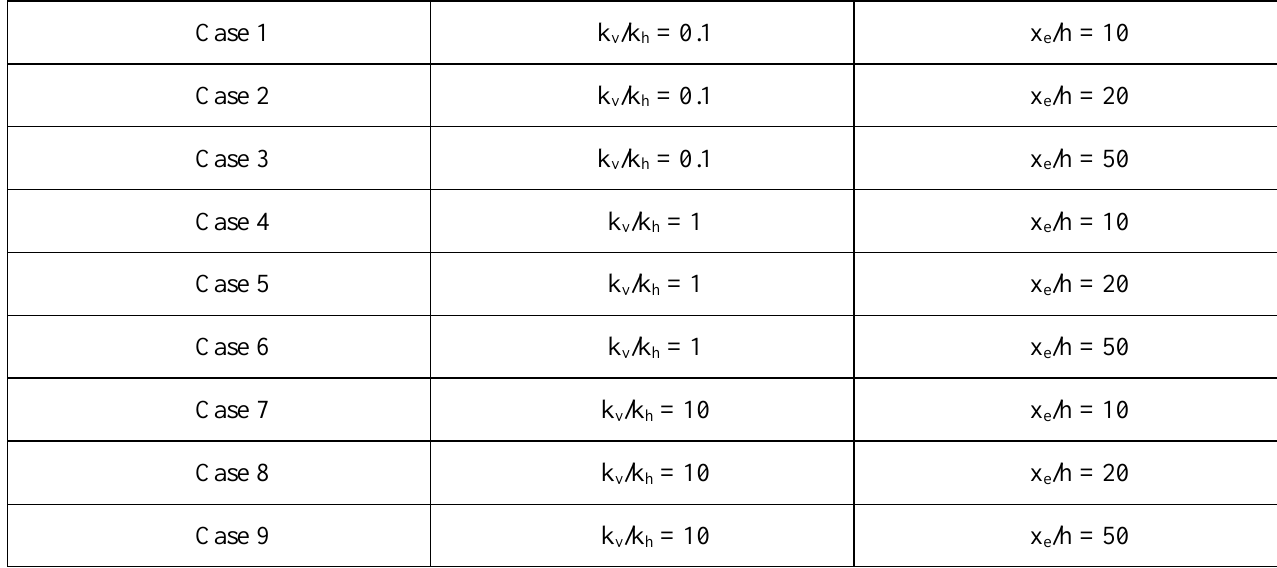
Table 2—Cases Designed for Eclipse